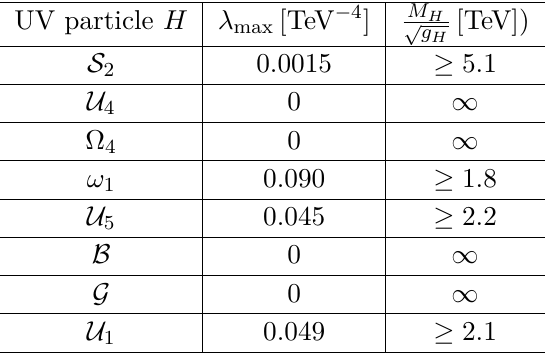
√ Table 6 . Lower bounds for the UV scale M H / g H assuming C 4 = 0 , C 5 = 0 . Strictly speaking, B here stands for the cases where θ 6 = 0 ; when θ = 0 , B becomes degenerate with S 2 , so one cannot tell the difference between them from the view point of the positivity cone. Similar understanding applies for the later tables where C 4 = C 5 = 0 .